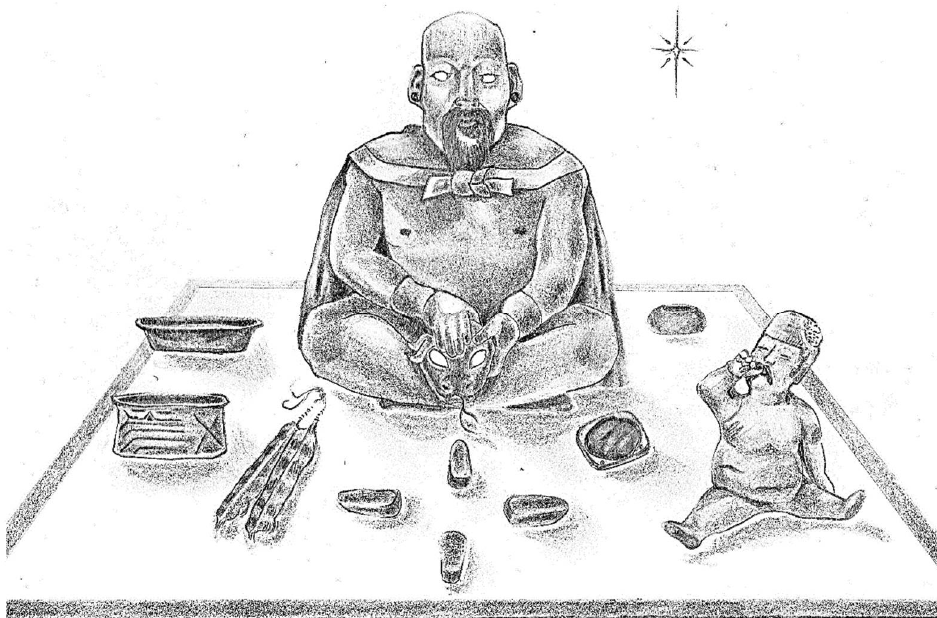
Figure 7. A rendition of the female clay-figurine from Las Bocas in the Valley of Mexico (see Guth- rie 1995, p. 314) showing multiple forms of night and early morning imagery. We see stars, com- ets, and full constellations. Among these are the Venus Star. Such pieces of pottery represented both planting guides, and precious gifts, shared among early Mesoamerican people. Drawing by 2nd author.